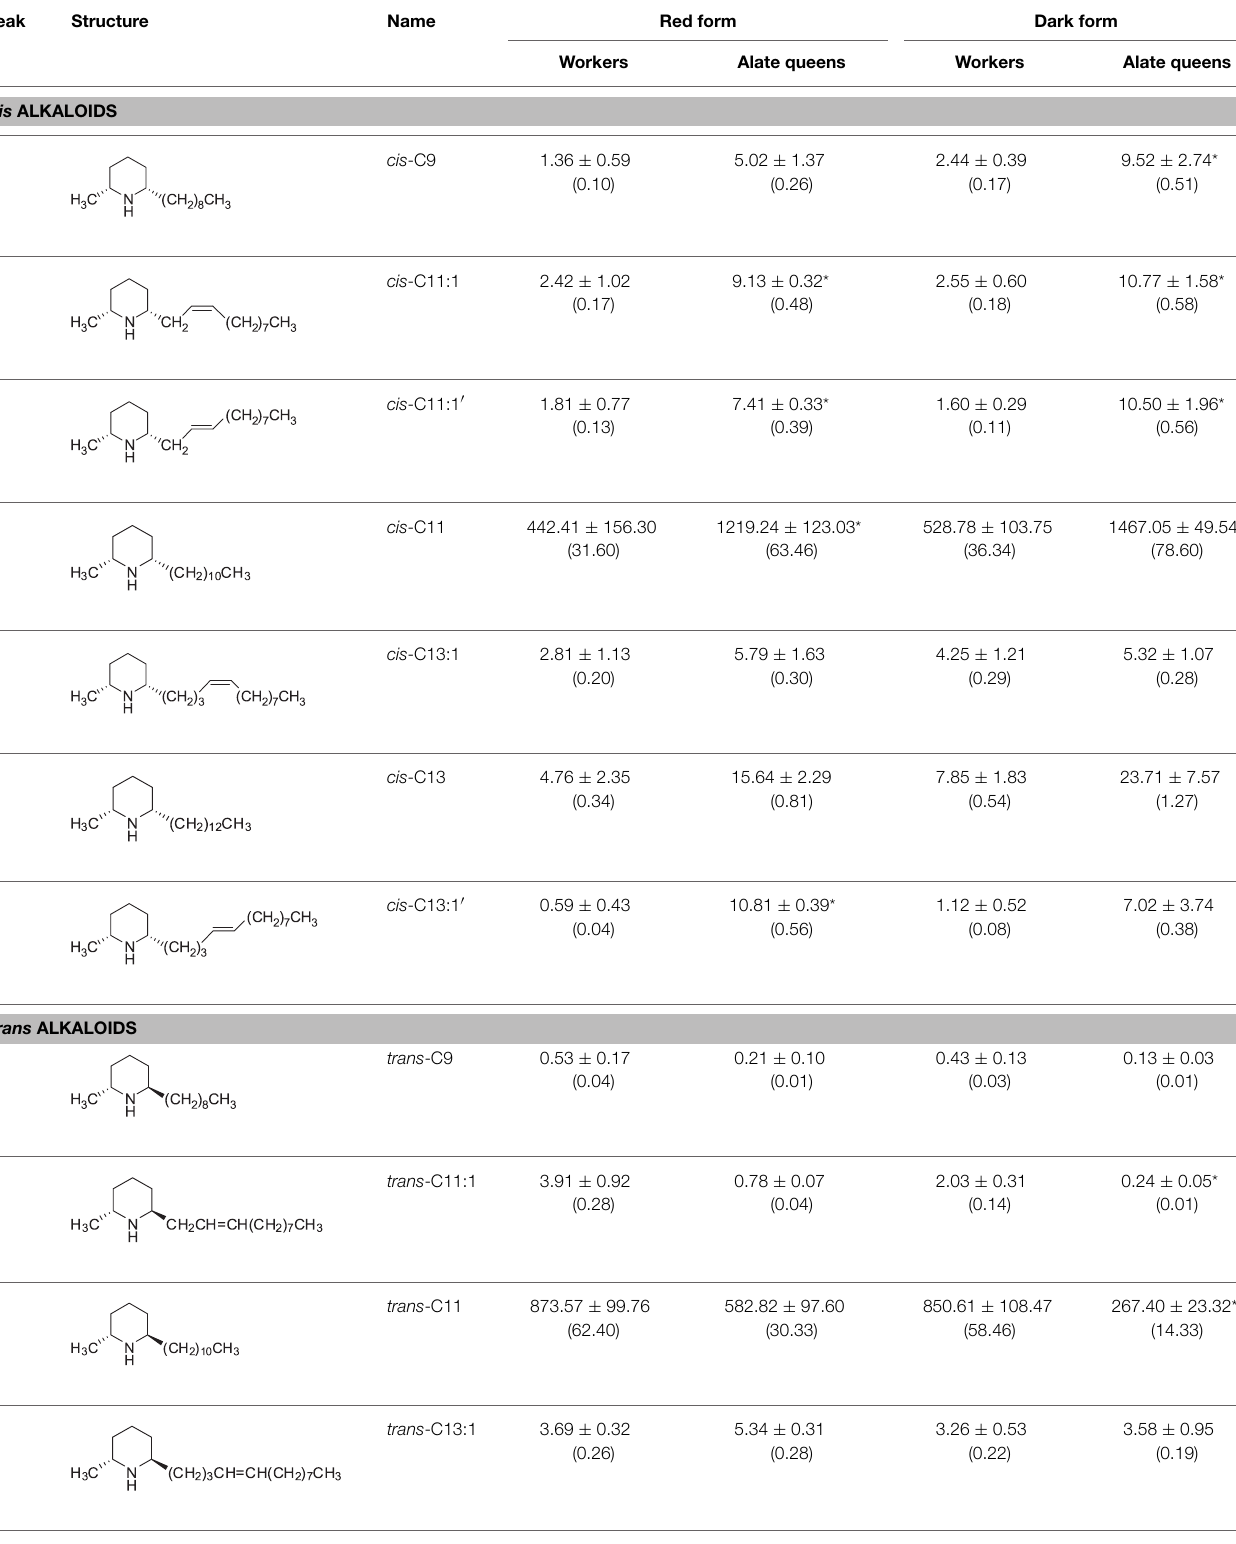
TABLE 1 | Quantitation of alkaloids from S. geminata fire ants ( µ g/g ± SE). Peak